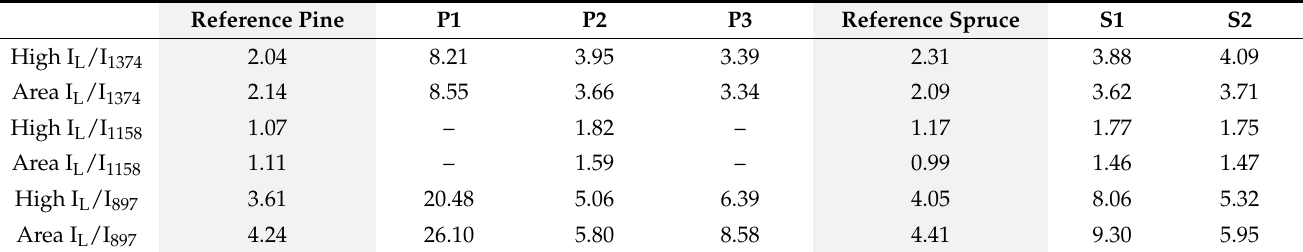
Table 1. Intensity of lignin (L, band at 1510 cm − 1 )/carbohydrate ratios (bands at 1374 cm − 1 and 1158 cm − 1 —cellulose and hemicelluloses; band at 897 cm − 1 —cellulose) obtained for archaeological and reference wood samples, described in Section